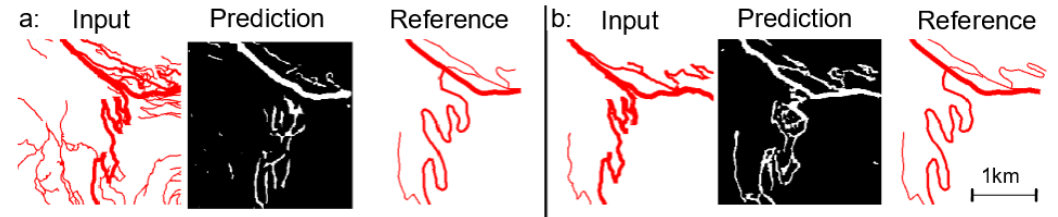
Figure 10. Comparison of prediction when the model is trained ( a ) without selection pre-process. ( b ) with selection pre-process.